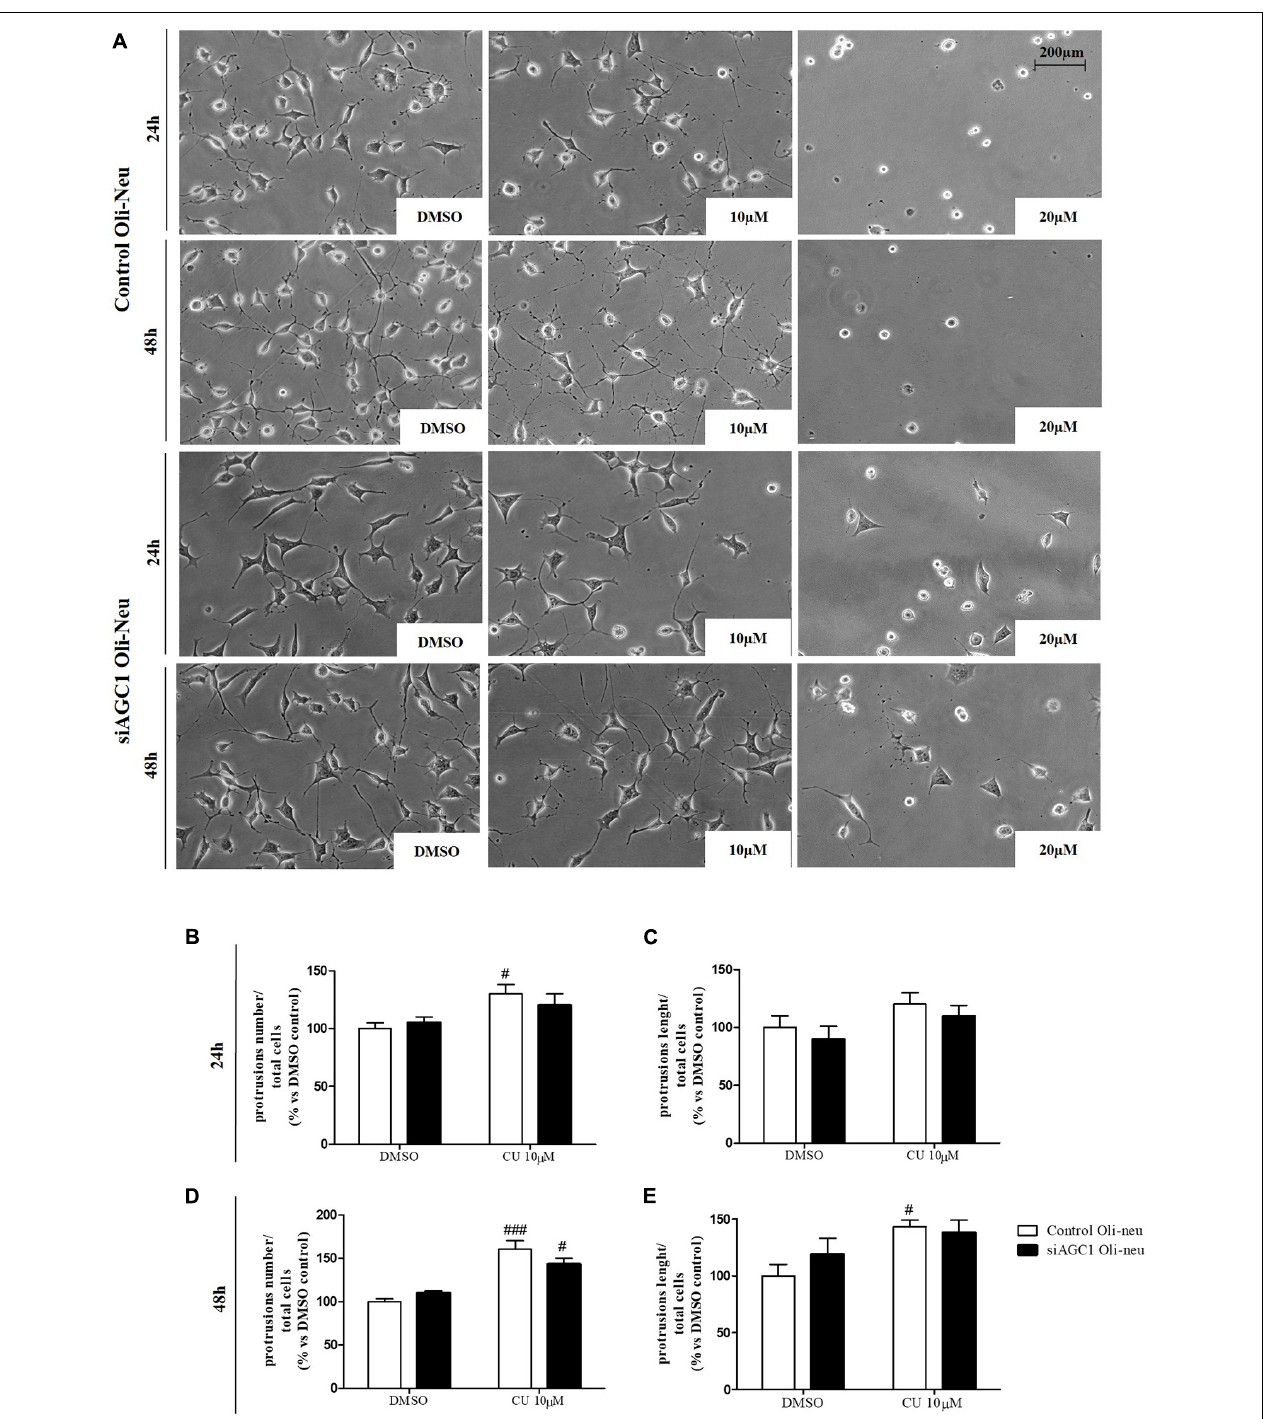
FIGURE 7 | After acetyltransferase CBP inhibition, cells appeared more elongated and branched, index of oligodendrocytes maturation, showing an increase in both processes number and average length compared to DMSO-treated controls. Optical microscope proliferation/differentiation analysis in control and siAGC1 Oli-Neu cells following 24 and 48 h of treatment with curcumin 10 and 20 µ M (A) . Filaments number and lengths were counted and measured, respectively, and analyses were carried out with Fuji Imagej2 software. Given the potential toxicity of curcumin 20 µ M, statistical analyses were executed only at 10 µ M (B–E) . Values are mean ± SD of 3 independent experiments; 3 different fields were acquired for each condition. 20X objective; 200 µ M bar scale. ### p < 0.001, # p < 0.05, compared to DMSO control, respectively; two-way ANOVA (Bonferroni’s post hoc test).